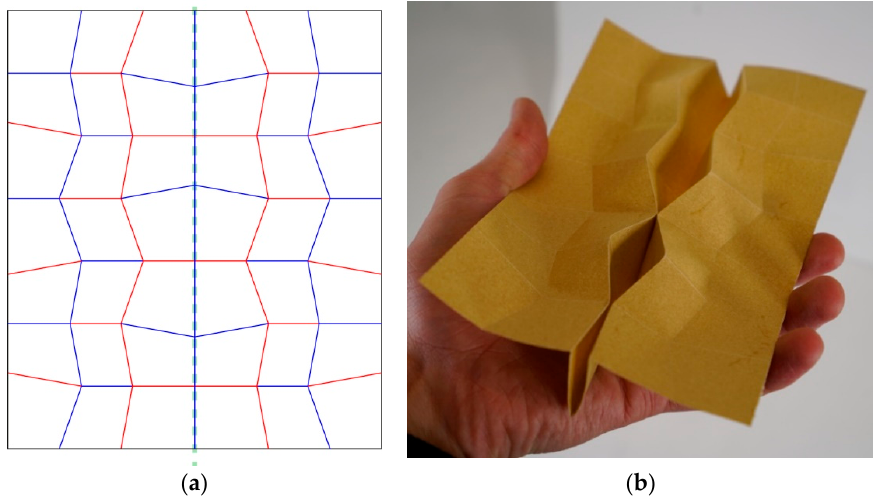
Figure 5. The folding pattern (#105a) presented in ( a ) was made from mirroring #104 along the green dash line and keeping this axis as a valley fold. ( b ) Displays the facing vertices or nodes blocking the folding process.